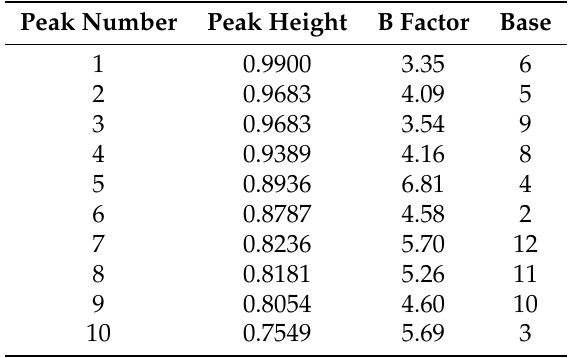
Table 3. Z-DNA phosphorus atoms found by SHELXD related to peak heights and refined B-factors.